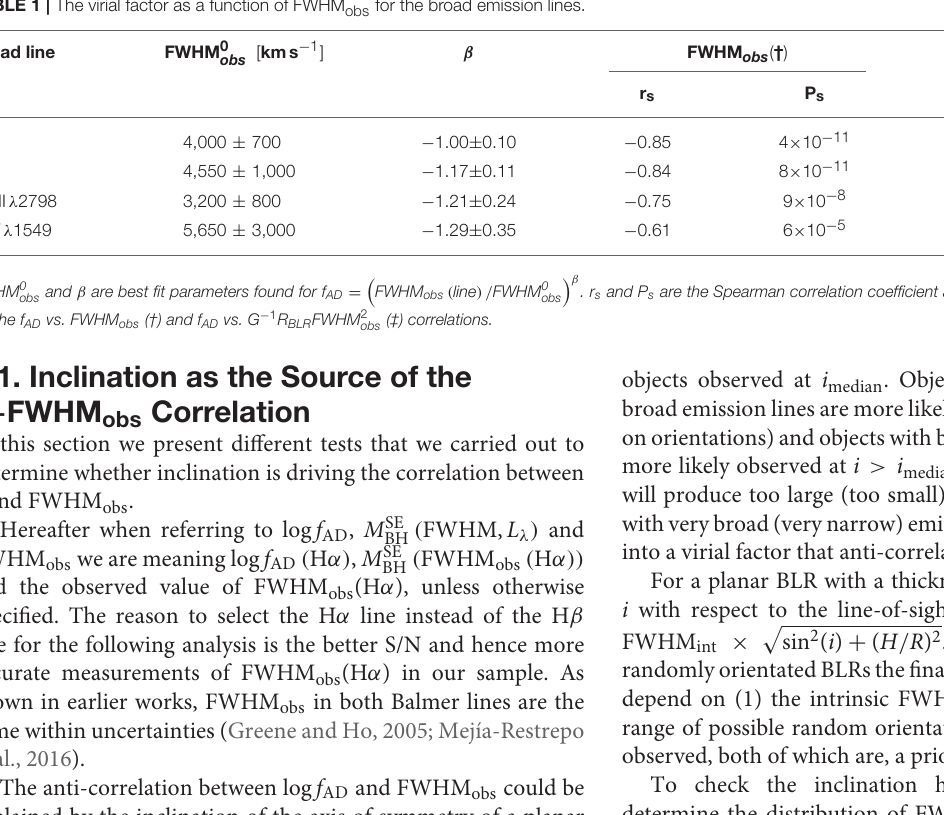
TABLE 1 | The virial factor as a function of FWHM obs for the broad emission lines. Broad line FWHM 0 obs [ kms − 1 ]